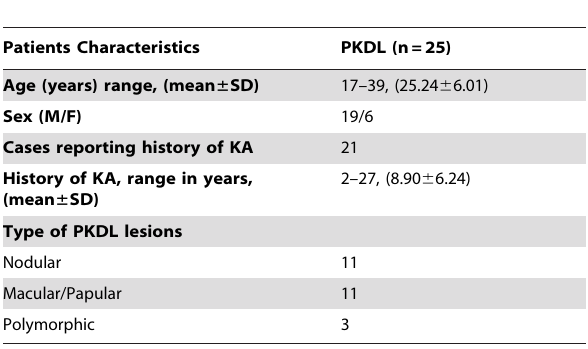
Table 1. Major characteristics of the study population.